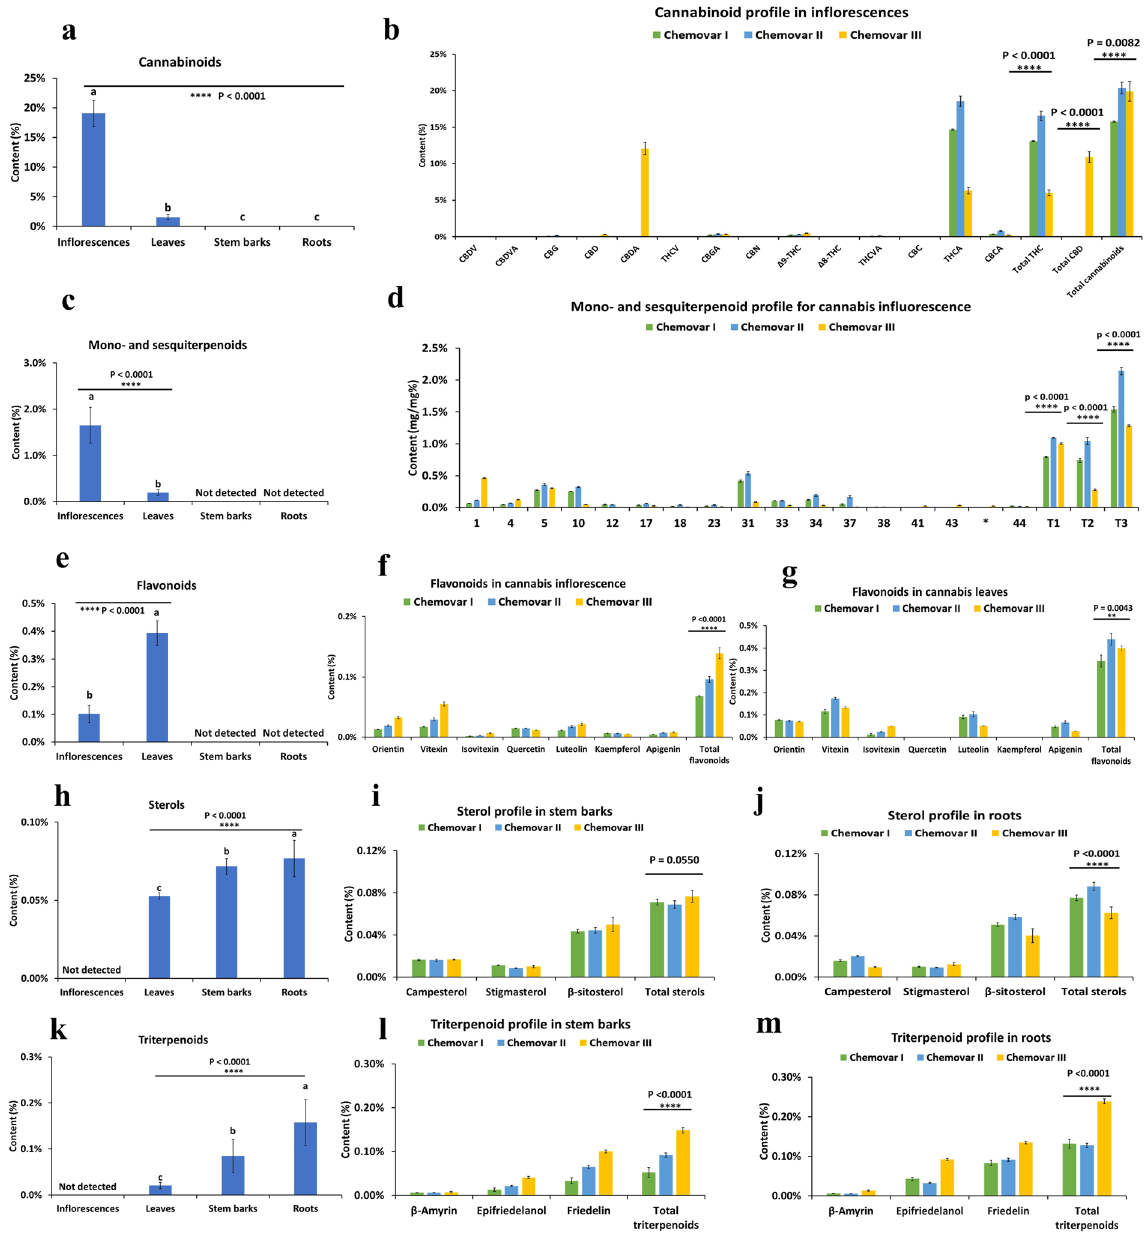
Figure 4. Secondary metabolites profiling in cannabis roots, stem barks, leaves, and inflorescences. ( a ) Total cannabinoid content (mg/mg%) in each part of cannabis plant averaged from three cannabis chemovars (n = 9, mean ± SD %). ( b ) Individual and total cannabinoid content (mg/mg%) in cannabis inflorescences of three chemovars (n = 3, mean ± SD %). Asterisks indicate statistically significant differences (one-way ANOVA, * p < 0.05, ** p < 0.01, *** p < 0.001, **** p < 0.0001). ( c ) Total mono- and sesquiterpenoid content (mg/ mg%) in each part of cannabis plant averaged from three cannabis chemovars (n = 9, mean ± SD %). ( d ) Individual and total mono- and sesquiterpenoids content (mg/mg%) in cannabis inflorescences of three chemovars (n = 3, mean ± SD %). Terpenoids labelled by their numbers are listed in Fig. 3e. The compound labelled as Asterisks was α -eudesmol, which was semi-quantified by GC-FID. T1 = total monoterpenoids. T2 = total sesquiterpenoids. T3 = total mono- and sesquiterpenoids. ( e ) Total flavonoid content (mg/mg%) in each part of cannabis plants averaged from three cannabis chemovars (n = 9, mean ± SD %). ( f ) Individual and total flavonoid content (mg/mg%) in cannabis inflorescences of three chemovars (n = 3, mean ± SD %). ( g ) Individual and total flavonoid content (mg/mg%) in cannabis leaves of three chemovars (n = 3, mean ± SD %). ( h ) Total sterol content (mg/mg%) in each part of cannabis plant averaged from three cannabis chemovars (n = 9, mean ± SD %). ( i ) Individual sterol content (mg/mg%) in cannabis stem barks of three chemovars (n = 3, mean ± SD %). ( j ) Individual sterol content (mg/mg%) in cannabis roots of three chemovars (n = 3, mean ± SD %). ( k ) Total triterpenoid content (mg/mg%) in each part of cannabis plant averaged from three cannabis chemovars (n = 9, mean ± SD %). ( l ) Individual and total triterpenoid content (mg/mg%) in